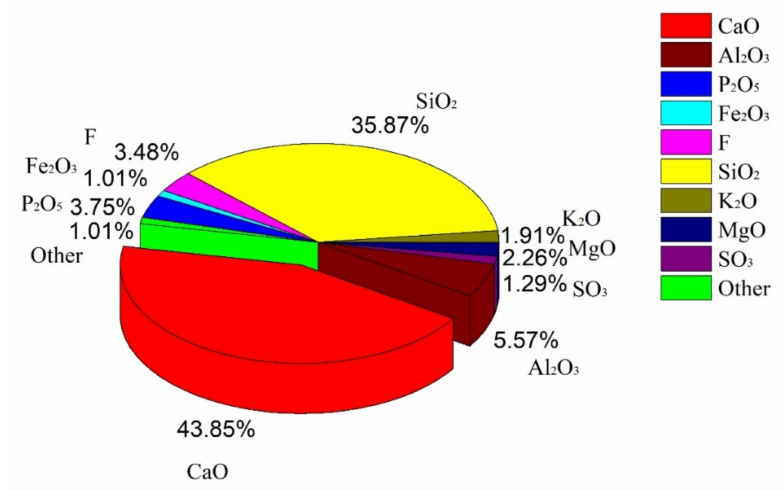
Figure 1. Chemical composition of phosphorous